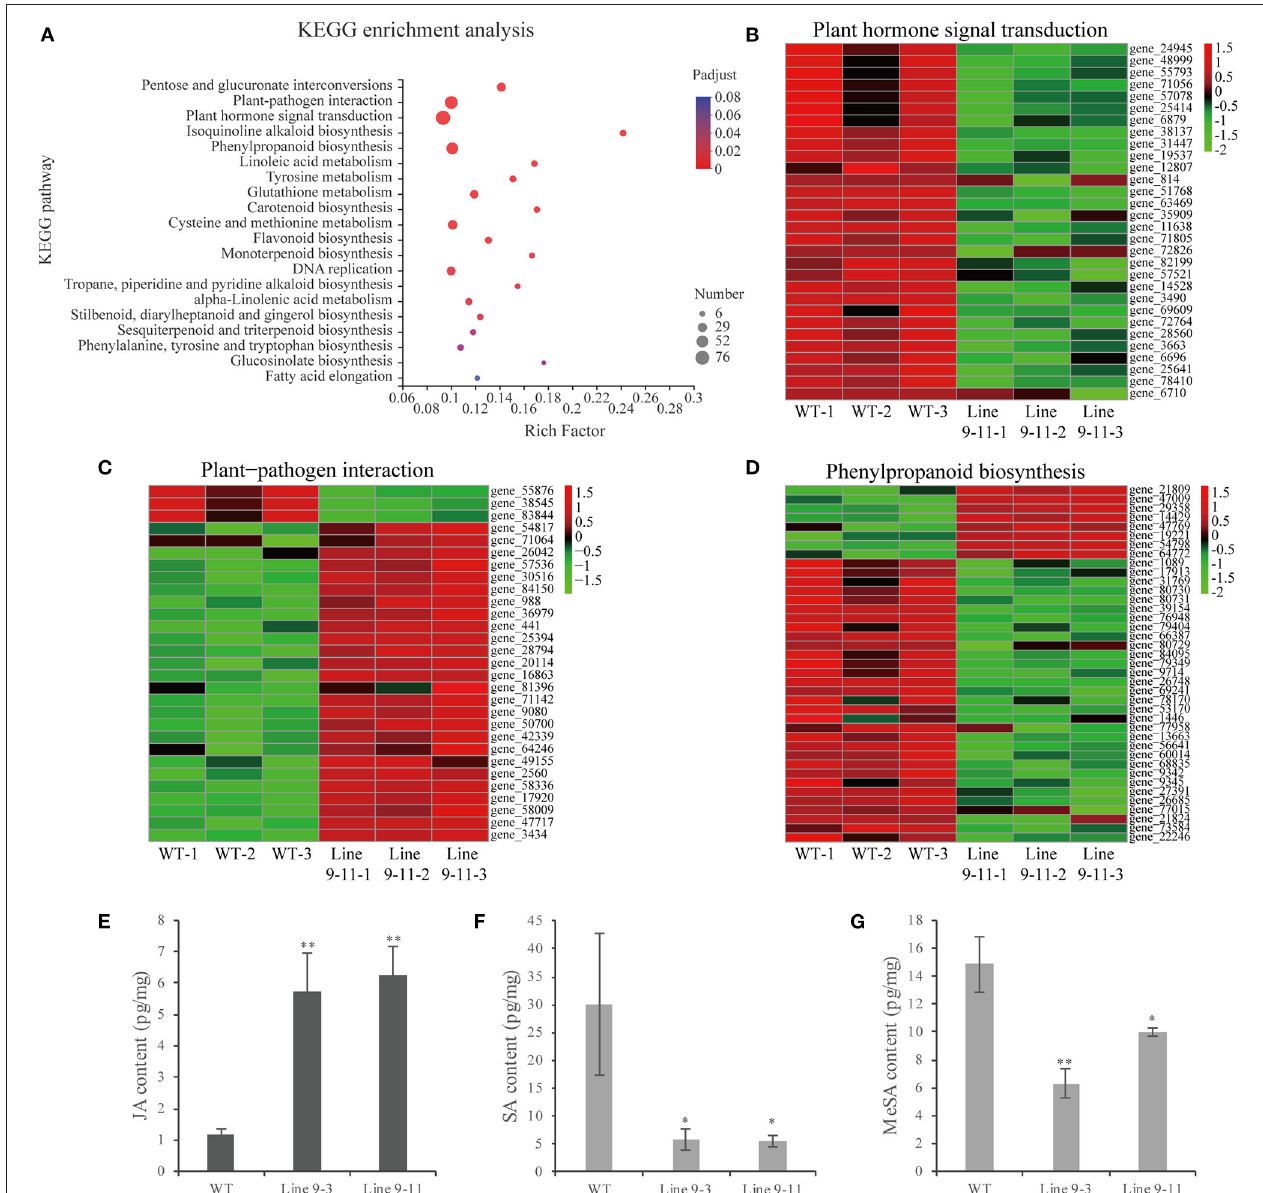
FIGURE 7 | RNA sequencing analysis and JA/SA content in PnWRKY9 -OE tobacco. (A) KEGG enrichment analysis of DEGs in PnWRKY9 -OE tobacco line 9-11 compared with WT tobacco. The color showed the significance level, and the bubble size indicated the numbers of the enriched genes. (B–D) DEGs heat map in plant hormone signal, plant-pathogen interactions, and phenylpropanoid biosynthesis pathways. The red and green indicated the up-regulated and down-regulated gene expression, respectively. (E–G) JA, SA, and MeSA contents in PnWRKY9 -OE tobacco line 9-3/11 and the WT tobacco (* p < 0.05; ** p <